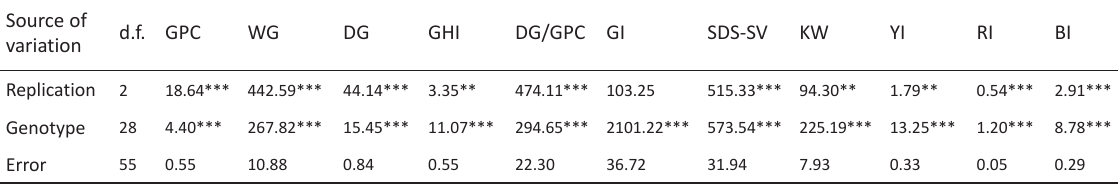
Table 4. Results of the analysis of variance carried out on grain protein content (GPC), wet gluten (WG), dry gluten (DG), gluten hydration index (GHI), dry gluten/protein ratio (DG/GPC), gluten index (GI), sodium dodecyl sulphate sedimentation volume (SDS- SV), thousand-kernel weight (KW), and color indices (YI = yellow index; RI = red index; BI = brown index) of whole meal of parental lines of wheat mapping populations grown in Valenzano (Bari, Italy) in